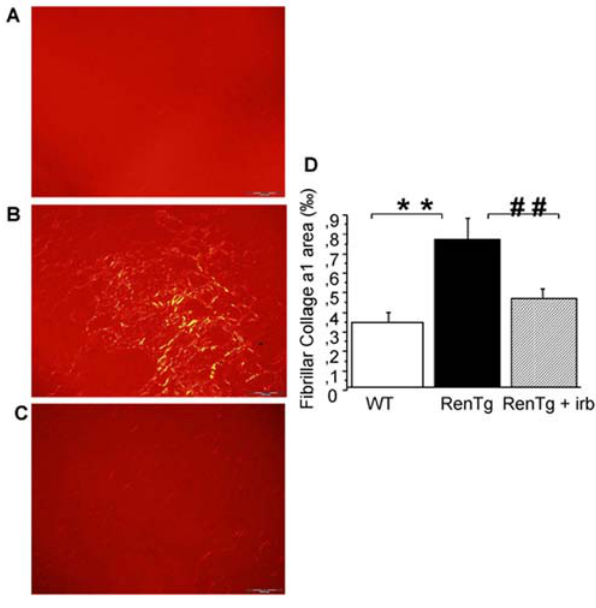
Figure 3. Decrease of renal fibrosis during AT1 receptor antagonism. Representative example of fibrillar collagen content in the renal interstitium revealed by Sirius red staining and polarized light in wild type (A) and RenTg mice before (B) and after (C) irbesartan treatment. Quantification by morphometric analysis is shown on the lower panel (D). Fibrillar collagen content was decreased to normal levels in RenTg mice after irbesartan administration. Values are are mean 6 SEM; n=5, 9 and 13 for wild type and RenTg mice before and after irbesartan, respectively; ** P , 0,01 vs WT; ## P , 0,01 vs RenTg. Bar=200 m